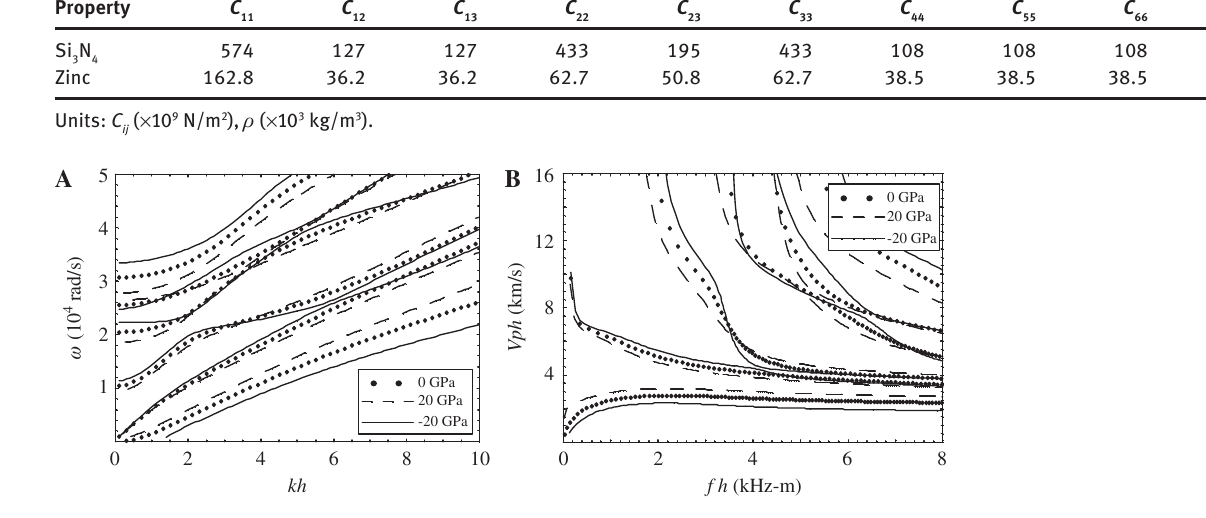
Figure 2 Circumferential Lamb-like wave dispersion curves for the linearly graded cylindrical plate under different radial initial stresses: (A) frequency spectra, (B) phase velocity